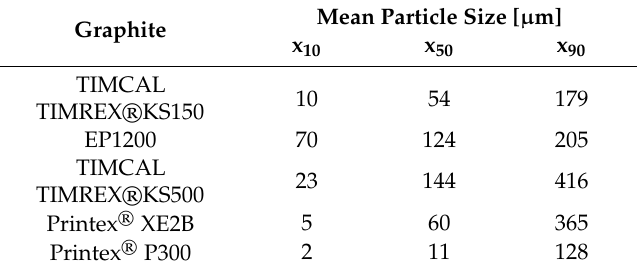
Table 2. Particle size of various kinds of graphite and carbon